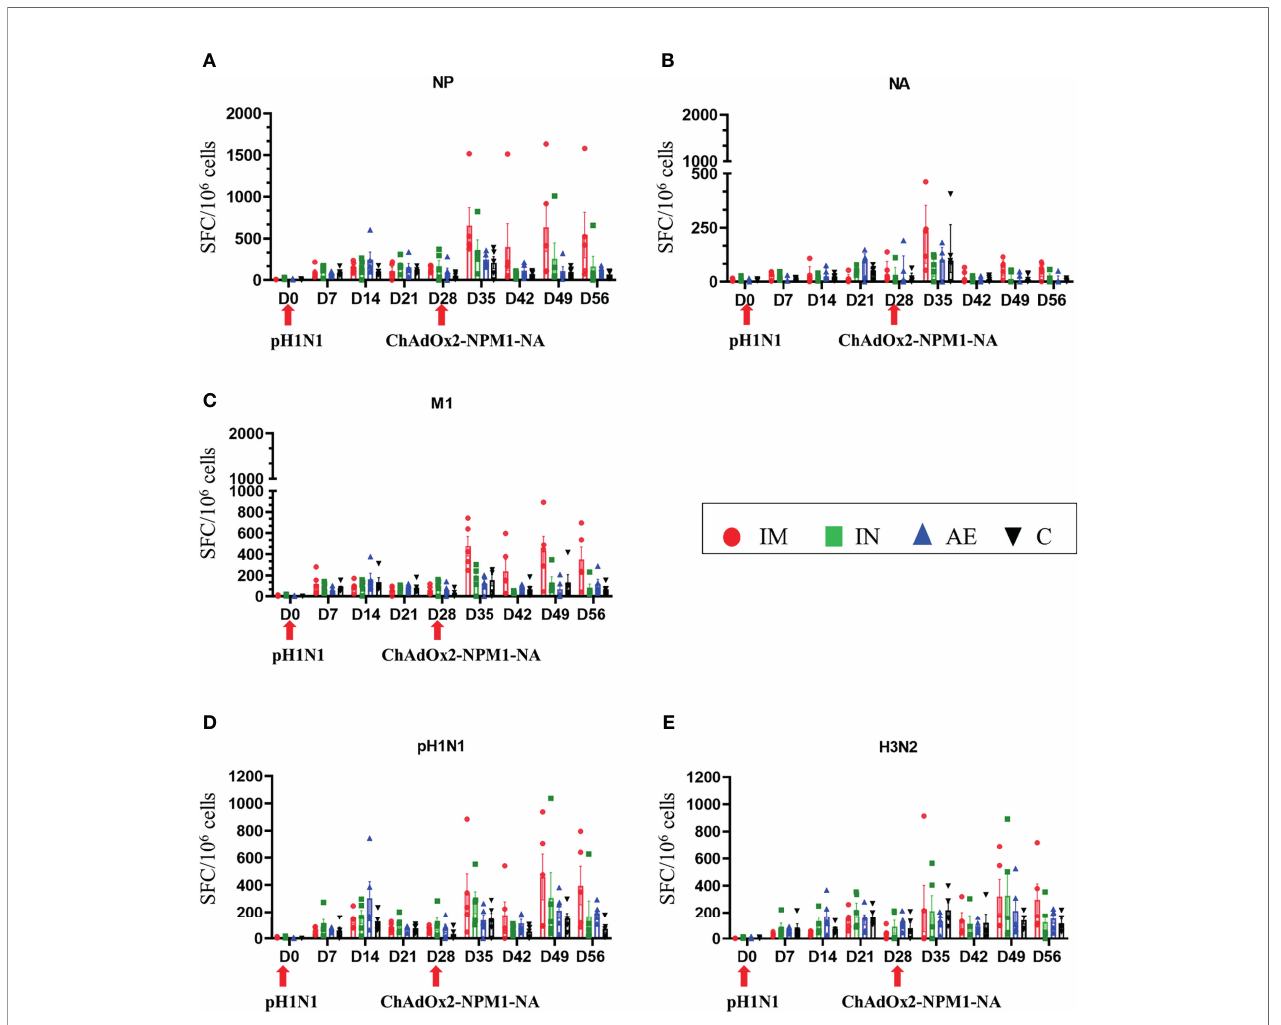
FIGURE 3 | IFN g ELISpot responses in PBMC. IFN g secreting spot-forming cells (SFC) were enumerated during the time course following stimulation with a pool of peptides covering (A) NP, (B) M1, and (C) NA proteins or (D) pH1N1 and (E) H3N2 viruses. The arrows below D0 and D28 indicate the challenge of the pigs with pH1N1 and the immunization with ChAdOx2-NPM1-NA, respectively. The C group was not immunized. Each symbol represents an individual animal, the top of the bar represents the mean, and the line the standard error (SEM) except for graph (B) , where the top of the bar indicates the median and the line the interquartile range. Signi fi cant statistical differences are listed in Table 2, 3.